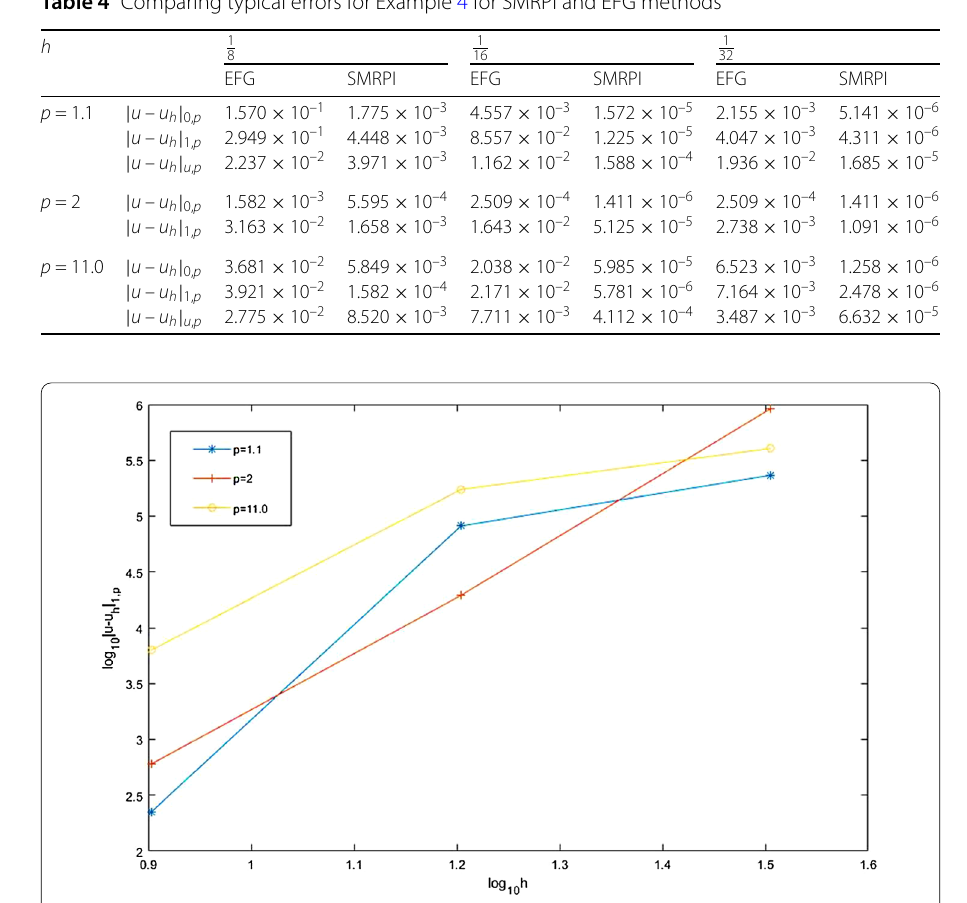
Figure 8 Graphs of the SMRPI solution with different values of p and h for Example